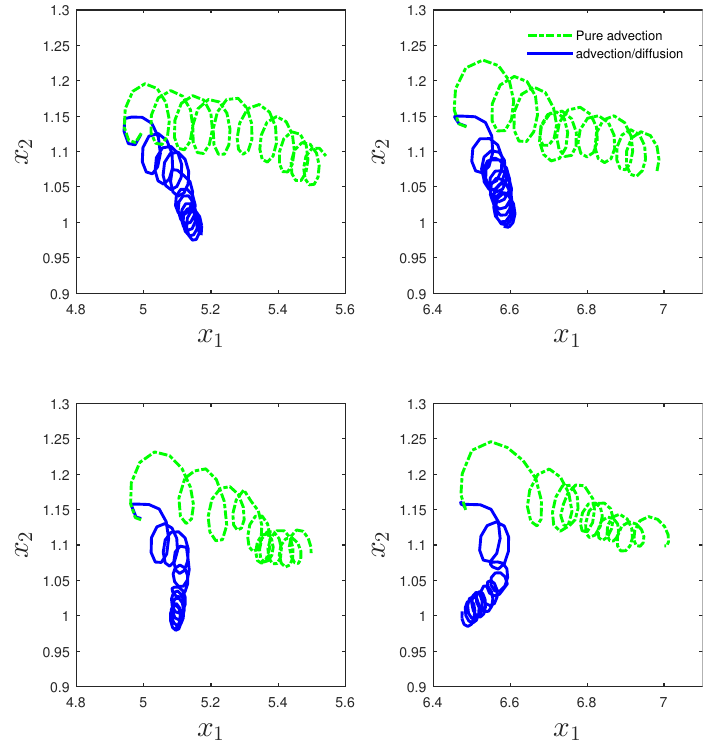
Figure 4. Ensemble averaged plume trajectory (over 1000 particles of each size) of neutrally buoyant particles . The particles were released at two different locations, x 1 ∈ [ 5.5,6 ] m, x 1 ∈ [ 6.5,7 ] m, x 2 = 1.15 m. The top panels correspond to the case with the wind body force f = 0.5 [N/M] and bottom panels correspond to the case with the wind body force f = 0.6 [N/M]. The panels on the left correspond to the particles in the x 1 ∈ [ 5.5,6 ] m location. The panels on the right correspond to the particles in the x 1 ∈ [ 6.5,7 ] m